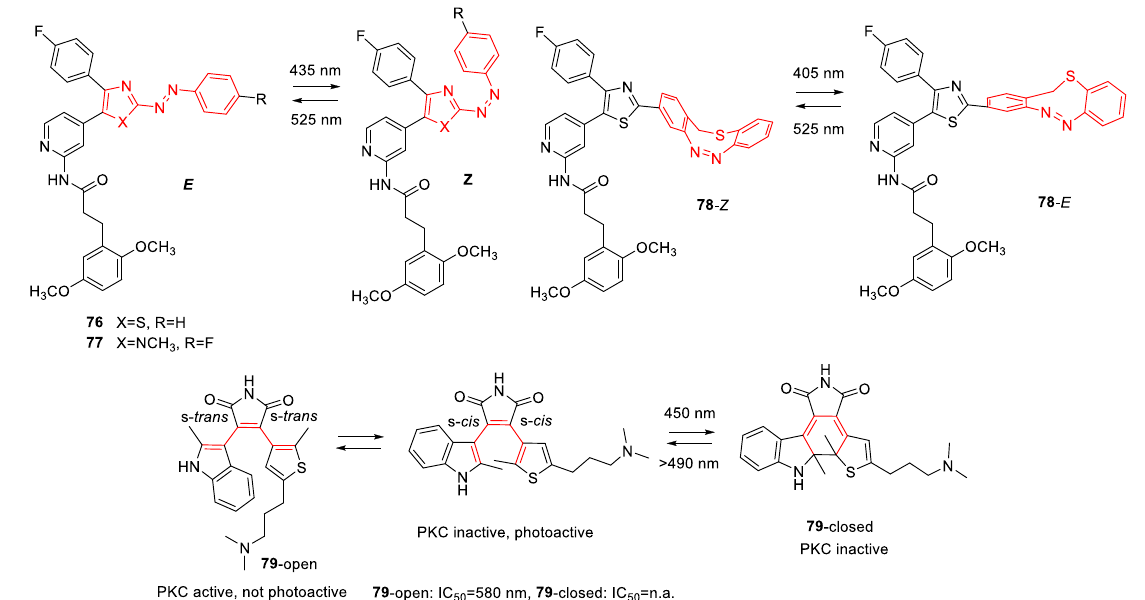
Figure 13. Photoswitchable kinase inhibitors, the photoswitch unit indicated in red. Branda and coworkers studied the design of photoactivatable protein kinase C (PKC) inhibitors using a diarylethene photoswitch scaffold [95]. Protein kinase C isoforms are involved in pathways related to the expression of genes affecting cell cycle